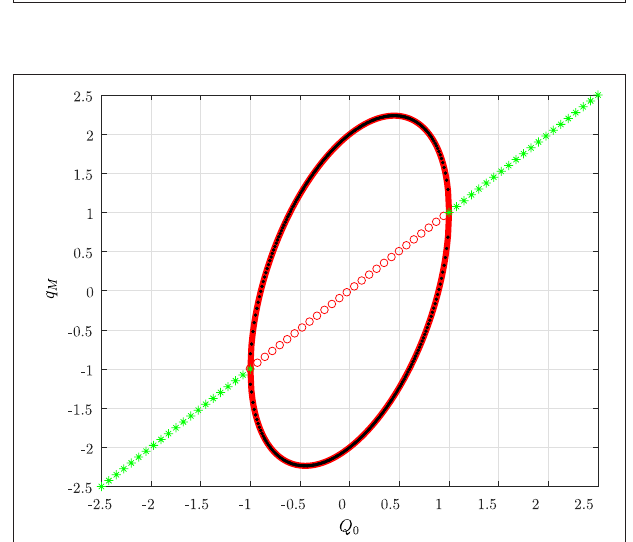
FIGURE 7 | True limit cycle (solid dark) and PLC (solid red) in the ( q M , i L )-plane for Q 0 0. =